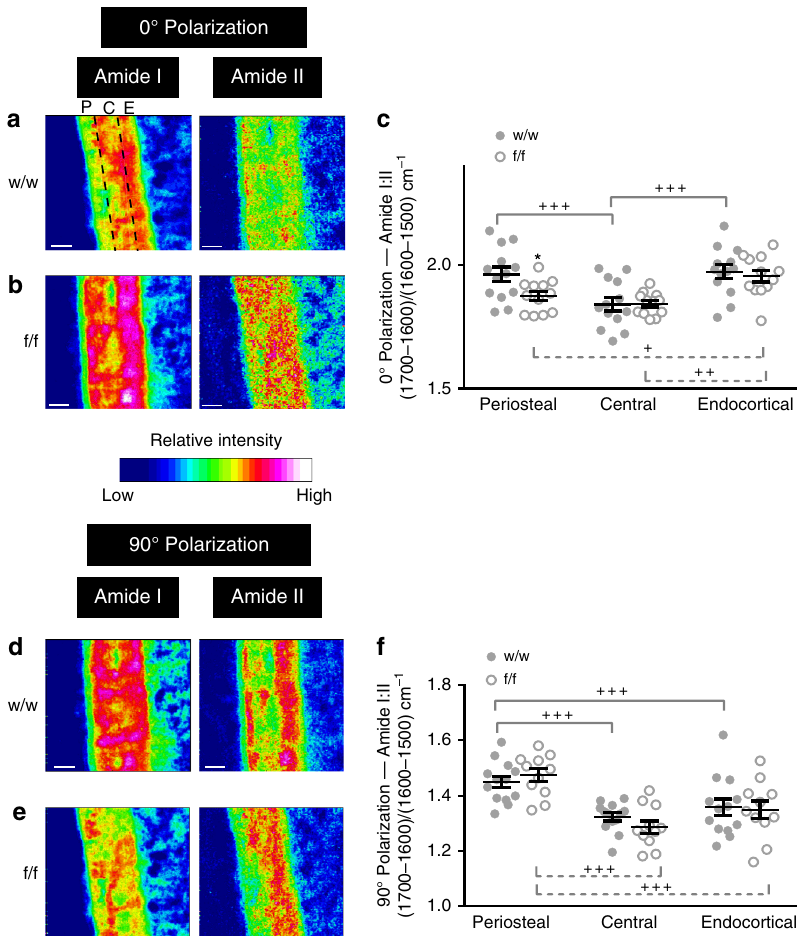
Fig. 4 Polarized Fourier-transform infrared (FTIR) imaging con fi rms altered collagen distribution in Dmp1Cre.Efnb2 f/f mice. Representative FTIR images showing relative intensity of amide I and amide II peaks in the cortical mid-shaft from 12-week old female Dmp1Cre (w/w) and Dmp1Cre.Efnb2 f/f (f/f) mice under the ( a , b ) 0° and ( d , e ) 90° polarizing fi lters; quanti fi cation of the amide I:II ratio under the 0° ( c ) and 90° ( f ) polarizing fi lters in periosteal (P), central (C) and endocortical (E) regions (shown in the top left of panel a). Data are mean ± SEM, n = 12 – 13/group. * p < 0.05 vs. Dmp1Cre at the same region (genotype effect), + p < 0.05, ++ p < 0.01, +++ p < 0.001 vs region indicated by the bracket, within the same genotype (region effect) by two-way analysis of variance (ANOVA). Scale bar = 50 μ